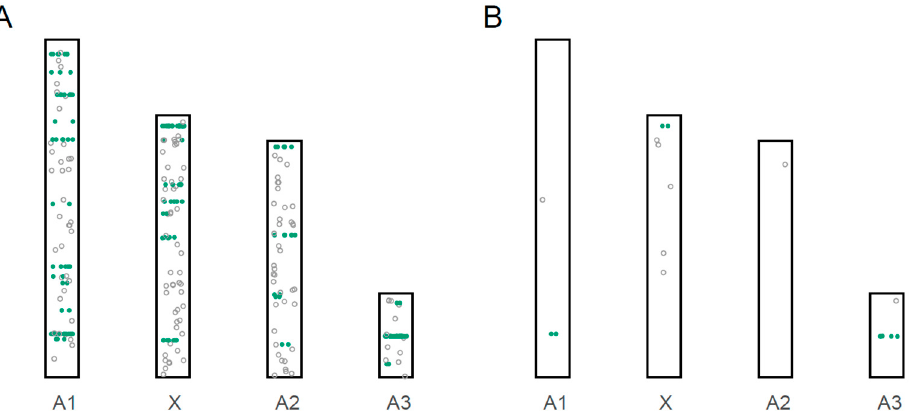
Figure 1. The distribution of miRNA coding loci across the four pea aphid chromosomes. ( A ) The distribution of all miRNA coding loci. ( B ) The distribution of highly male-biased miRNA coding loci (5 × higher in males compared to females). Clusters are indicated by green, solid circles, while non-cluster miRNAs are indicated by open circles.